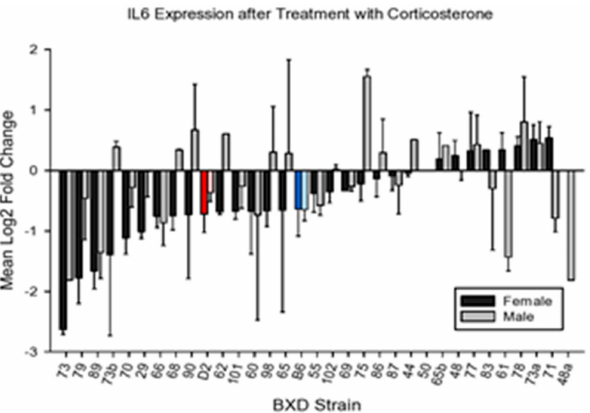
Figure 4. Mean change ( ± s.e.m) vs. control in ll6 expression in prefrontal cortex following 7 days of corticosterone in the drinking water and 6h following intraperitoneal injection with normal saline.